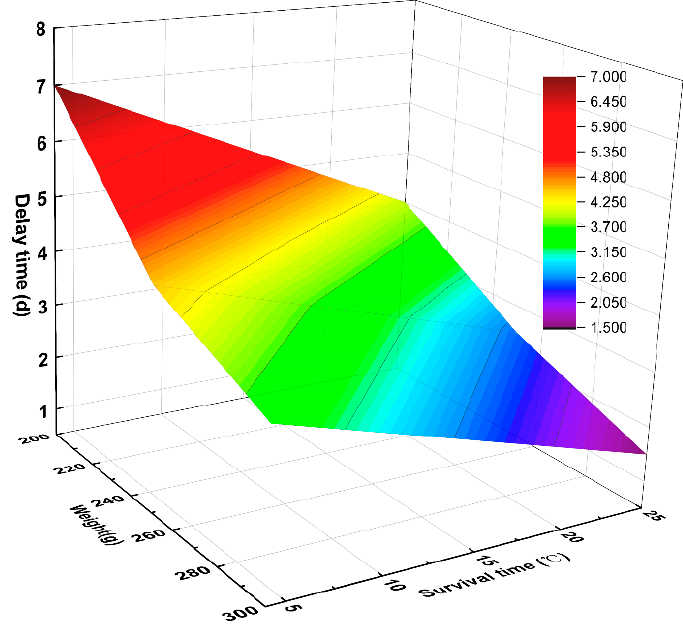
Figure 9. Analysis diagram of SCS delay characteristics.